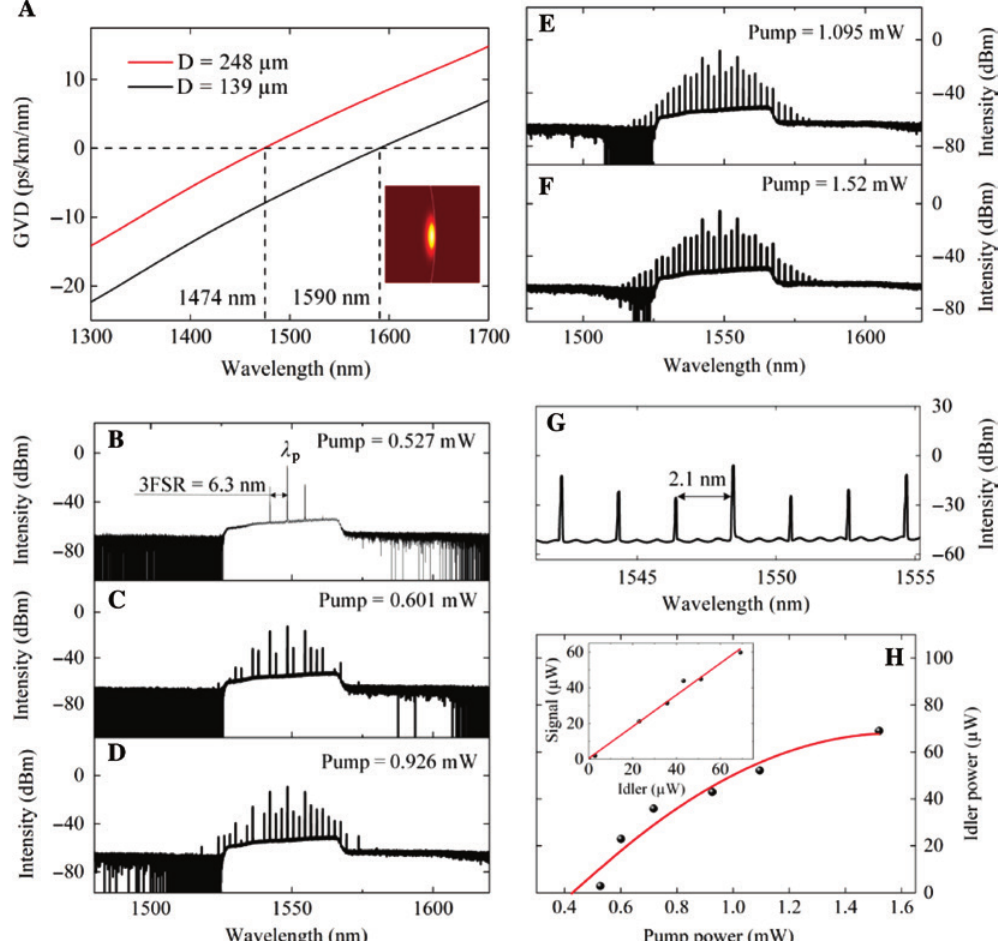
Figure 3: Kerr frequency comb generation. (A) Calculated total group velocity dispersion curves of the functionalized silica microsphere resonators with diameters of 248 and 139 μ m, respectively. The inset is the fundamental mode field pattern of the microsphere resonator with a diameter of 248 μ m. (B–F) Kerr frequency comb formation in the functionalized microsphere resonator with a diameter of 248 μ m. (G) Zoom-in spectrum of Figure 3F. (H) Idler power as a function of the pump power. The inset shows the relation between the idler power and the signal